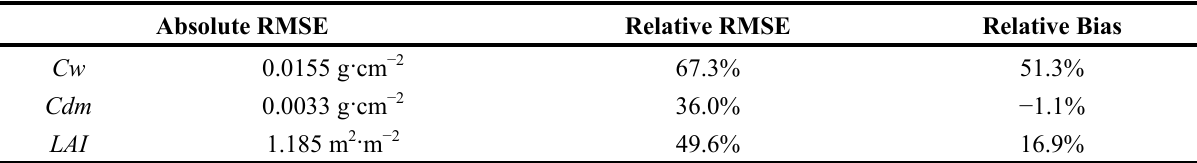
Table 8. Absolute and relative RMSE, and relative bias between in situ measurements of Cw , Cdm and LAI and estimates obtained from field spectrometer measurements using predictive